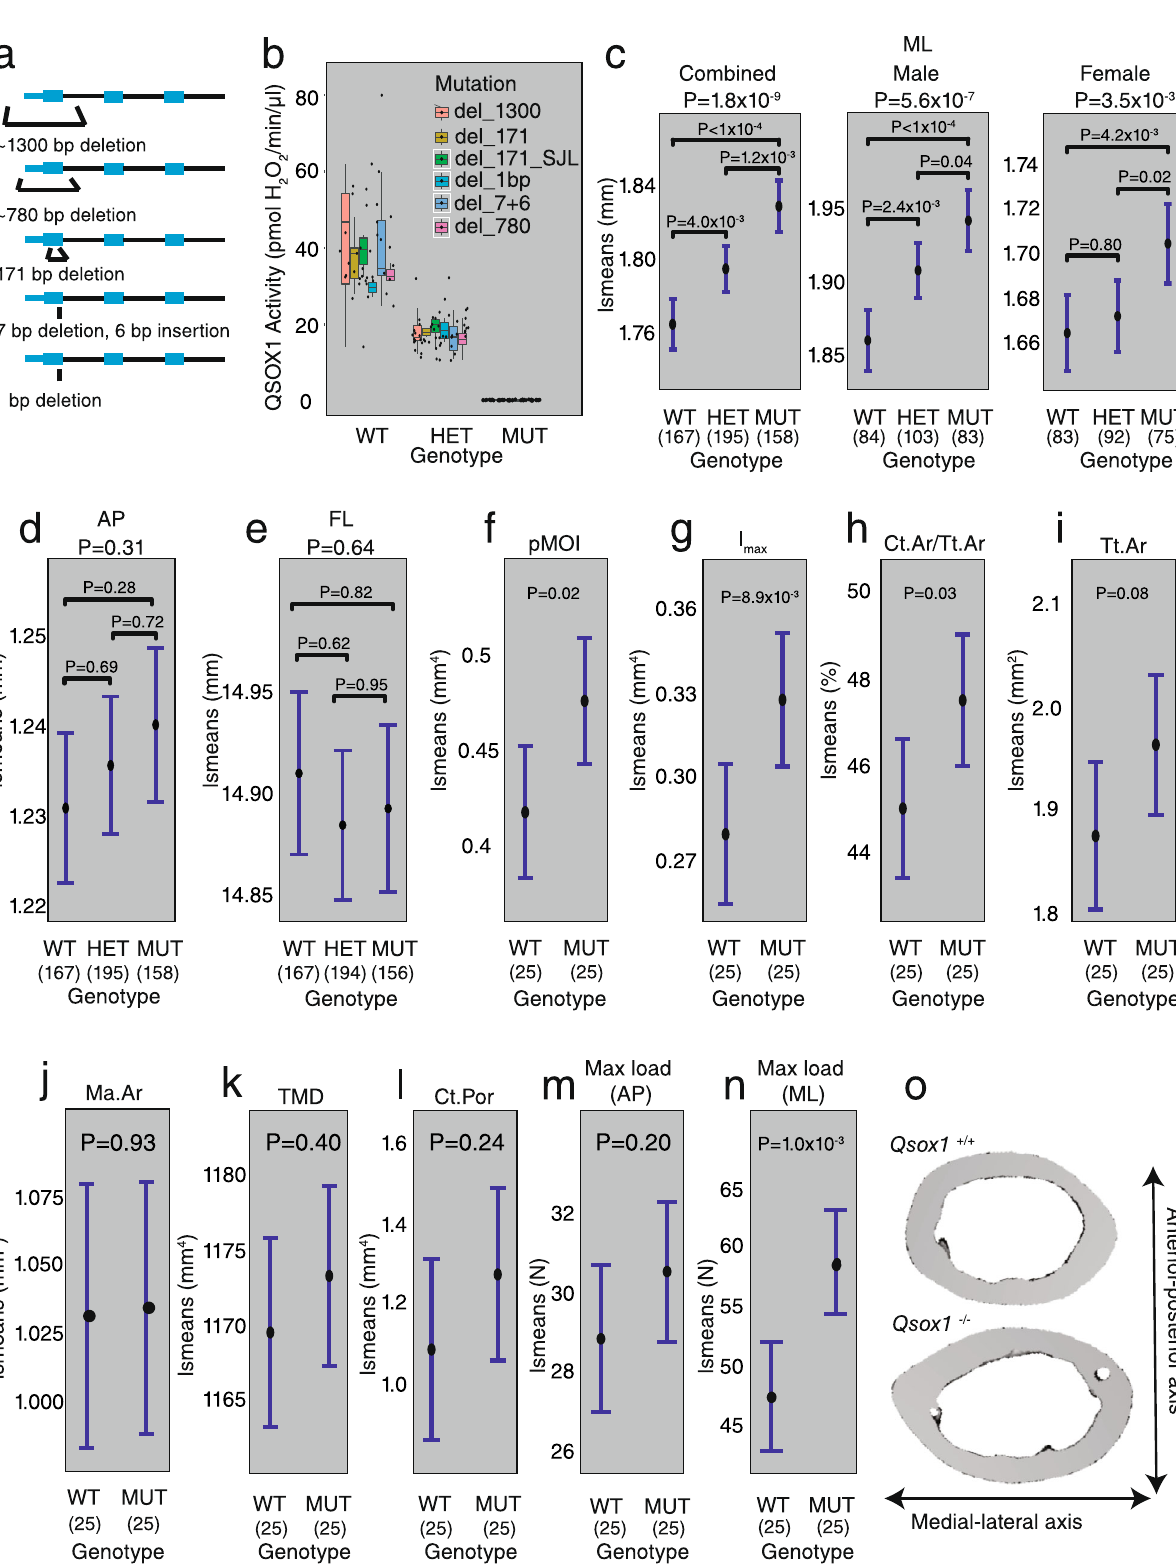
Given the strength of locus 1 on bone morphology and its association with biomechanical strength, we were surprised the locus did not impact femoral strength. Typically, in four-point bending assays, the force is applied along the AP axis.